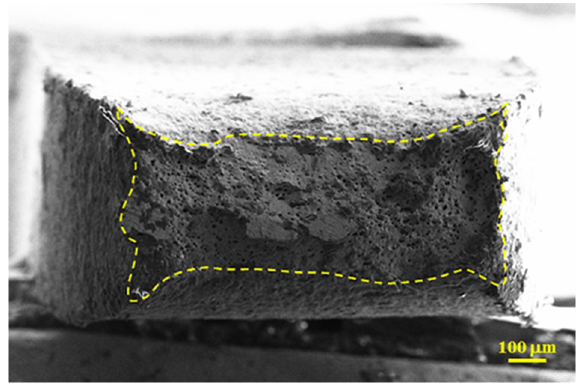
Figure 2. Fracture area calculation using ImageJ software.